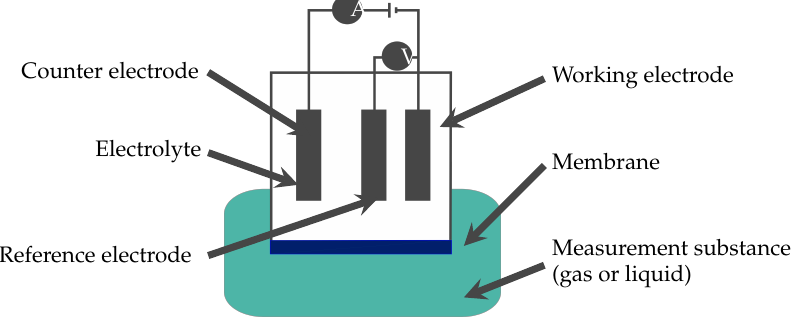
Figure 4. Schematic of an amperometric sensor. Between the working and reference electrode, a constant voltage is applied. The current, measured at the working electrode, changes when ozone is present in the measurement